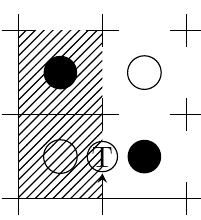
Figure 63. B-timer, abbrev.